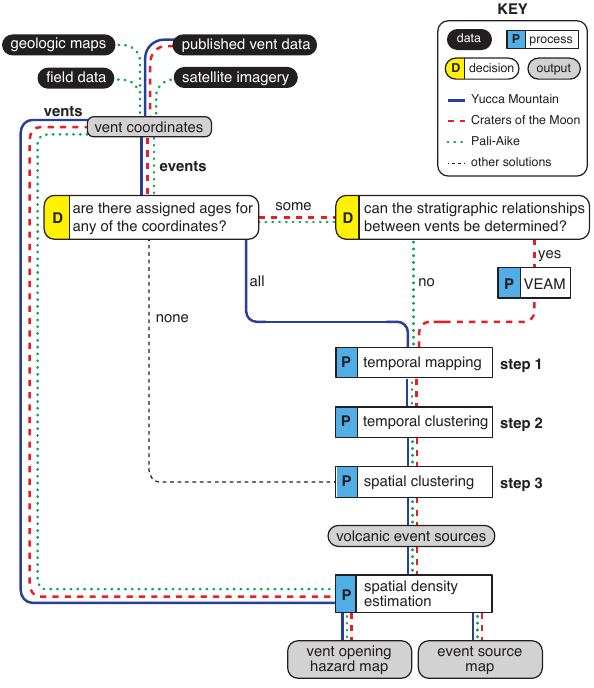
Figure 3: Flow chart for event source determination and vent opening hazard modelling. The steps taken to model event sources for Yucca Mountain, Pali-Aike and COM are noted in blue solid, green dotted, and red dashed lines, respectively. An additional workflow for datasets that do not have age determinations is noted by the dashed black line. We highlight the specific event classification steps (1, 2, and 3) on the diagram and de- scribe them in the text of Section 3.1 (Event Modelling Code).